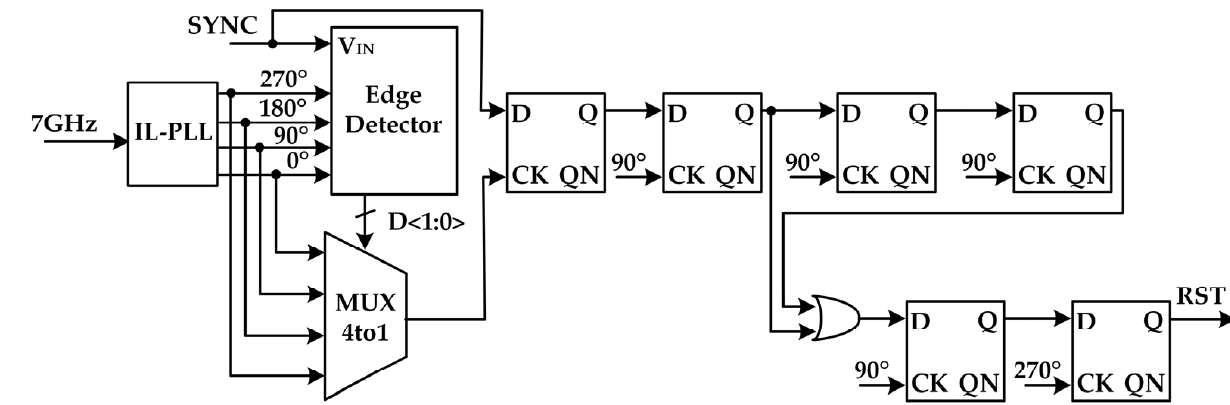
Figure 10. Edge detector and phase selector.